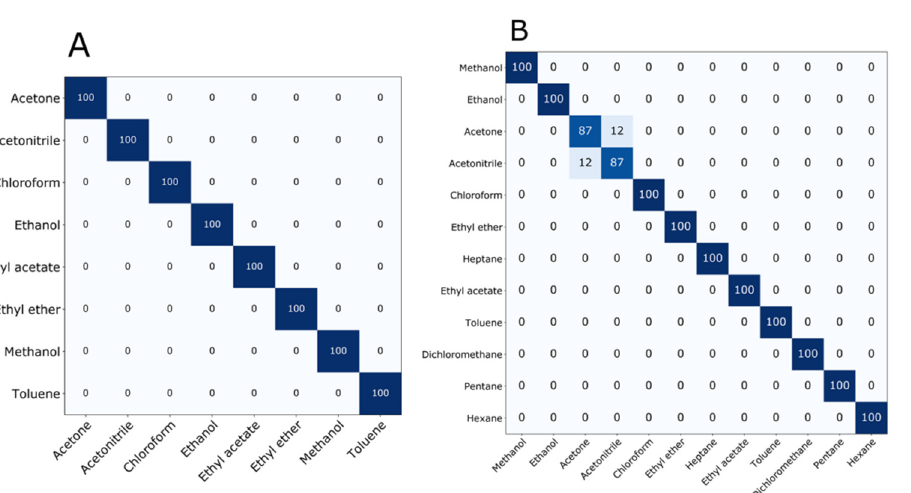
Figure 9. Comparison of the accuracies of the different classifiers used for set A and set B sensors.